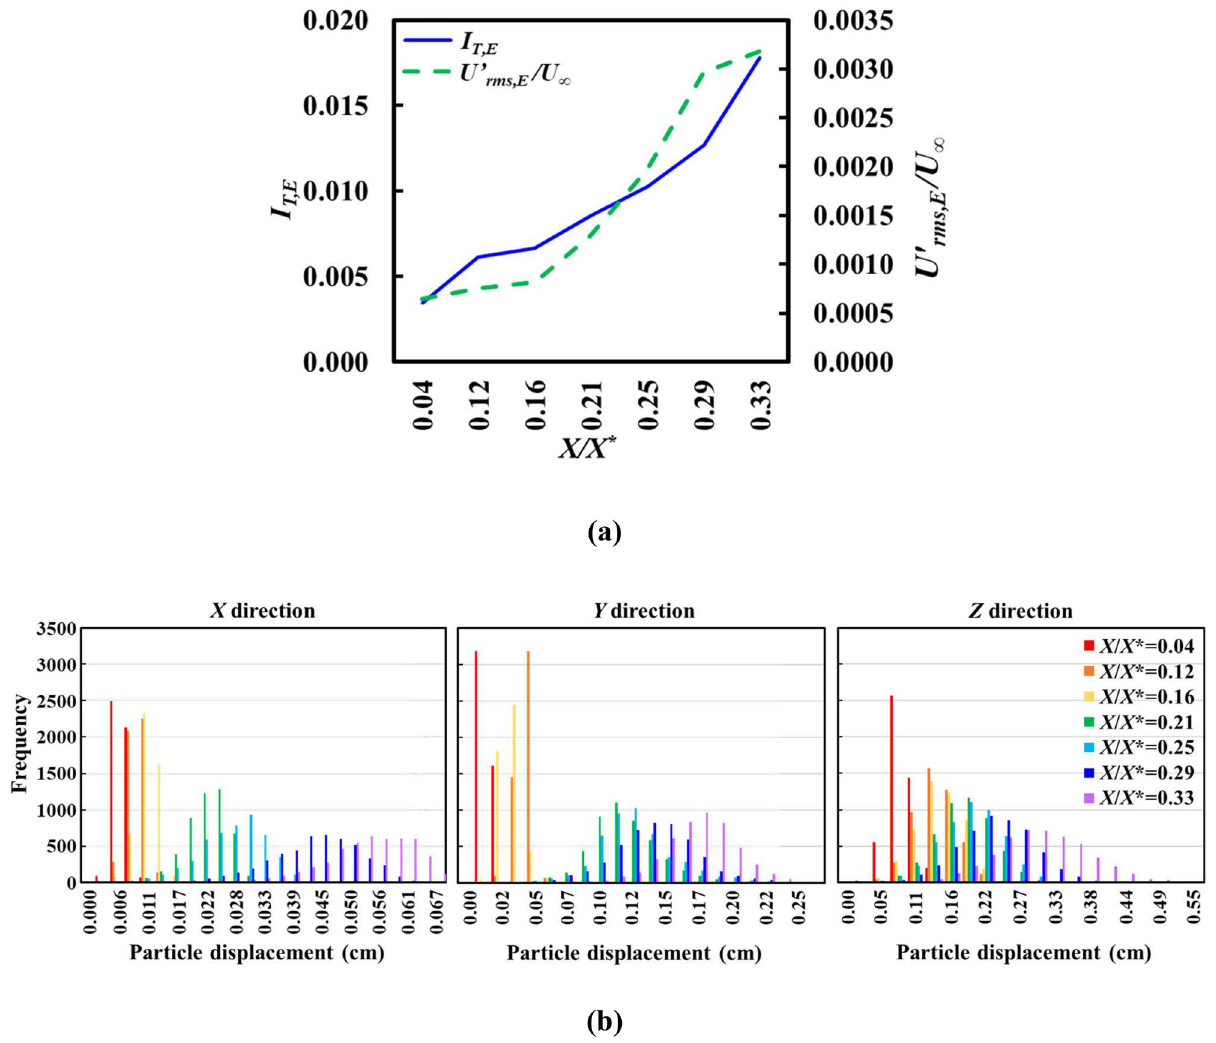
Figure 8. SFG generated centreline ( a ) I T,E and U’ rms,E / U ∞ , and ( b ) the particle displacement histogram in X , Y , and Z direction at various distances leeward of fractal grid obtained via